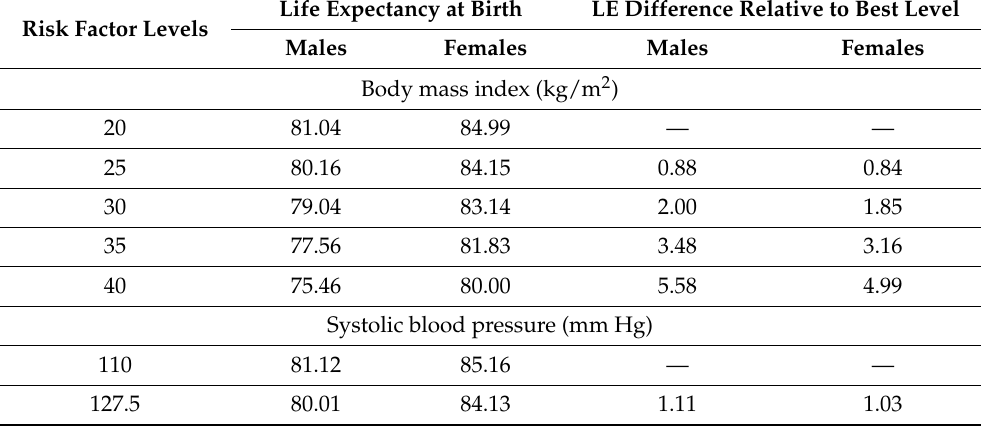
Table 3. Life expectancy at birth for selected levels of 7 metabolic risk factors and differences relative to optimal